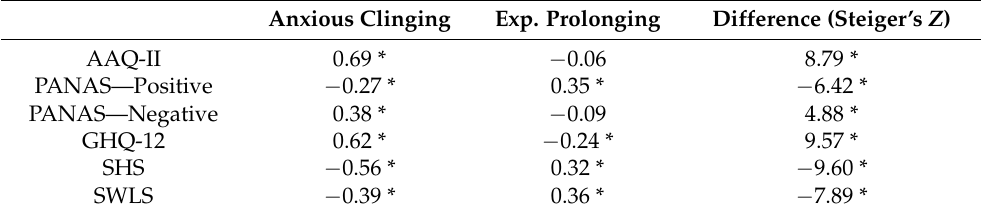
Table 4. Pearson correlations between each EAS subscale and other relevant self-report measures. Anxious Clinging Exp. Prolonging